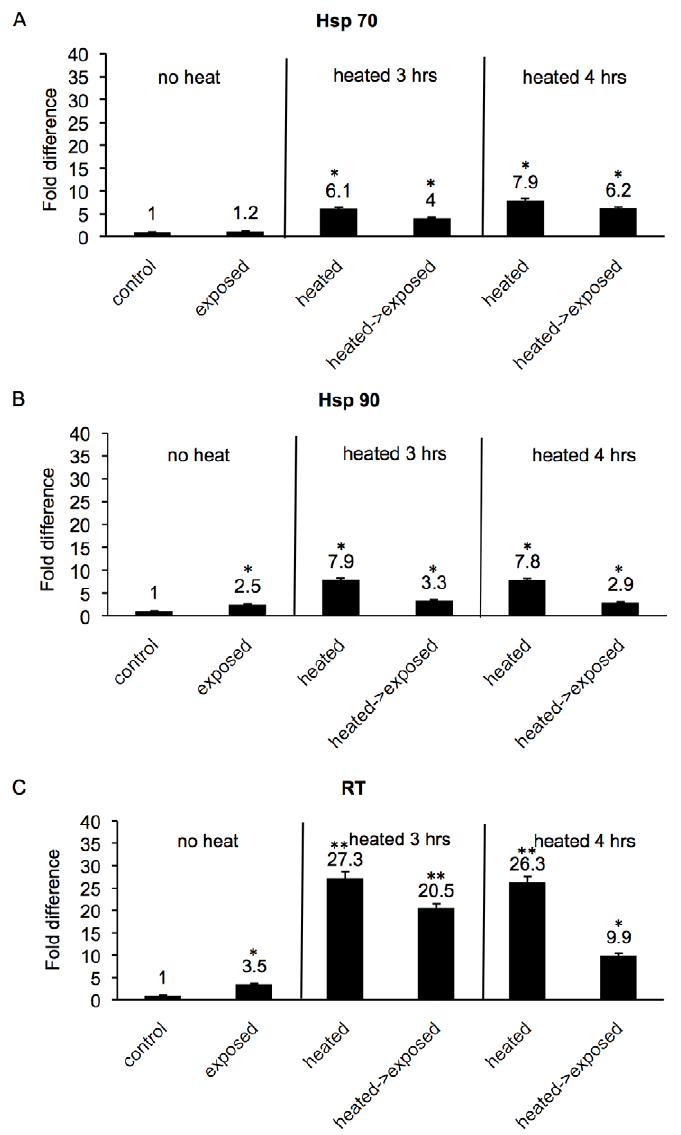
Figure 2. The differential expression of transcripts encoding Hsp 70, Hsp 90 and RT in parasite - exposed, heat-pulsed -parasite- exposed BS-90 juvenile snails. Real time qPCR examination of fold differences in expression of Hsp 70 (panel A), Hsp 90 (panel B), and RT (panel C) in normal BS-90 (control), S. mansoni exposed, heat-pulsed (32 u C), and heat-pulsed combined with immediate parasite exposure. All exposures were done for 2 hrs using snails that were either not subjected to heat-pulse (no heat), or kept for 3 and 4 hrs at 32 u C prior to exposure. The histograms represent pooled data from 5 independent experiments, each performed with RNA (assayed in triplicate) isolated from 10 individual size- matched juvenile snails. The asterisk * and ** indicates statistical significant P-values of , 0.05 and , 0.01, respectively analyzed by Student t -test (N=50).